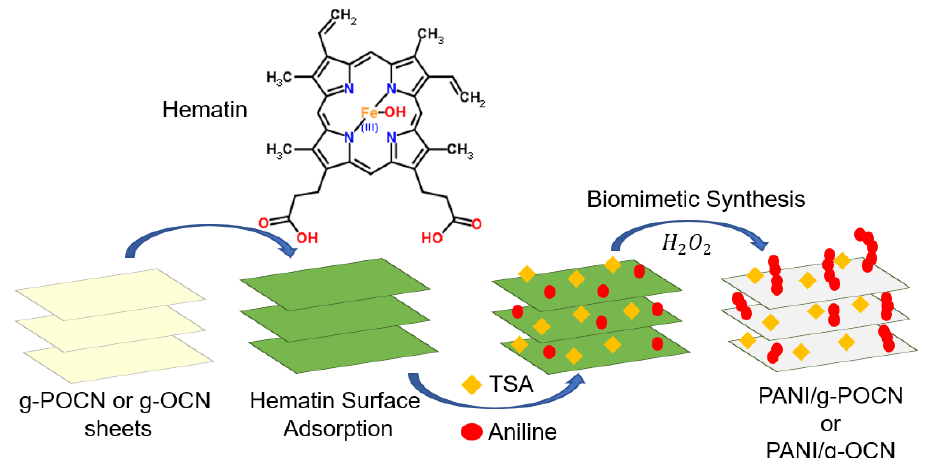
Figure 1. General diagram of the synthesized PANI/g-C3N4 supercapacitor composites.